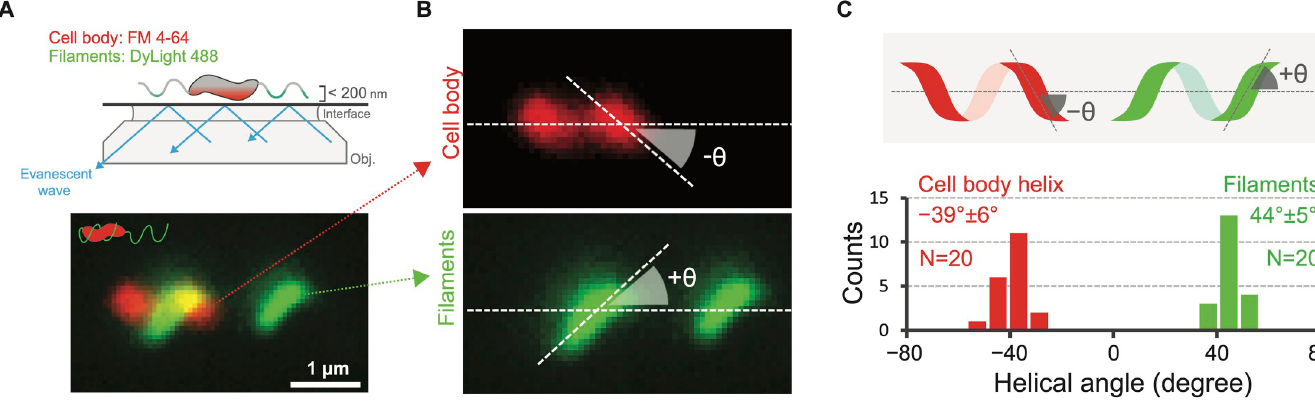
Fig 3. The cell body and flagellar filament have opposite handedness. TIRFM revealed that the cell body is a right-handed (RH) helix, while the filament assumes a left-handed (LH) helical conformation ( A and B ), and that the filament remains a LH helix whether it is wrapped or unwrapped. The pitch of both the flagellar filament and cell body are approximately identical at ~40˚ ( C